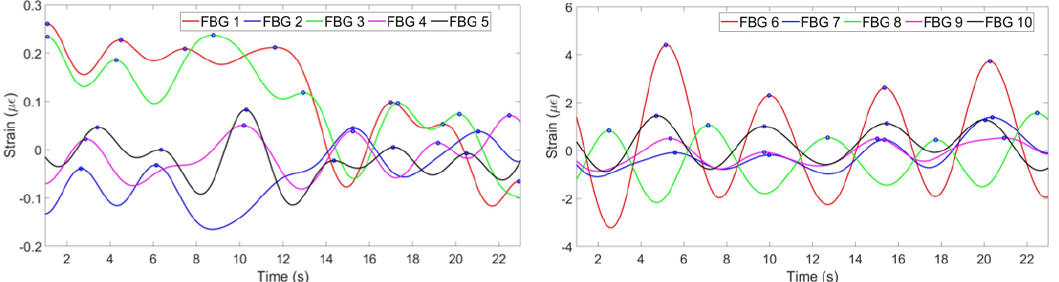
Figure 16. Breathing pattern for the second volunteer in the sitting position detected by: FBGs on the chest ( left ) and abdomen regions ( right ).